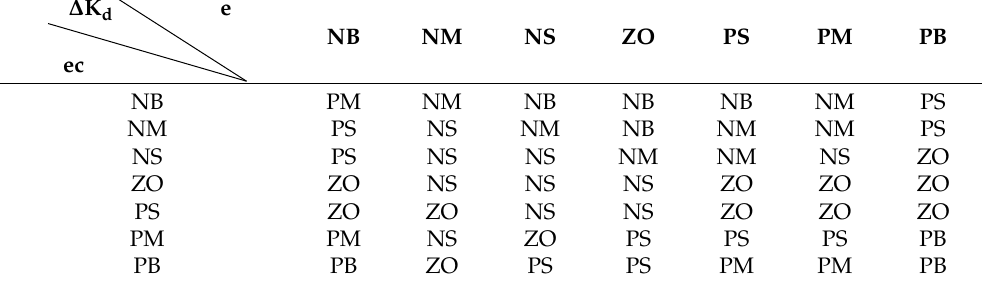
Table 5. ∆ K d Fuzzy control rule